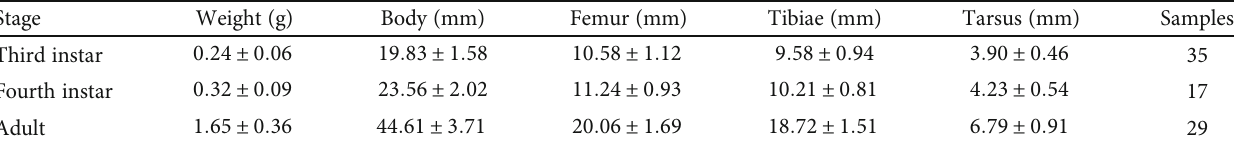
Table 1: Weight and linear dimension parameters characterizing the tested third instars, fourth instars and adults of Locusta migratoria